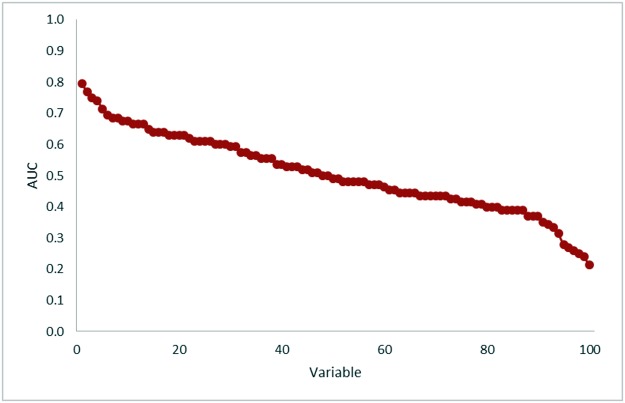
Area under the curve (AUC) values from receiver operating characteristic (ROC) analysis of 100 random variables.The variables are ordered by decreasing AUC values.